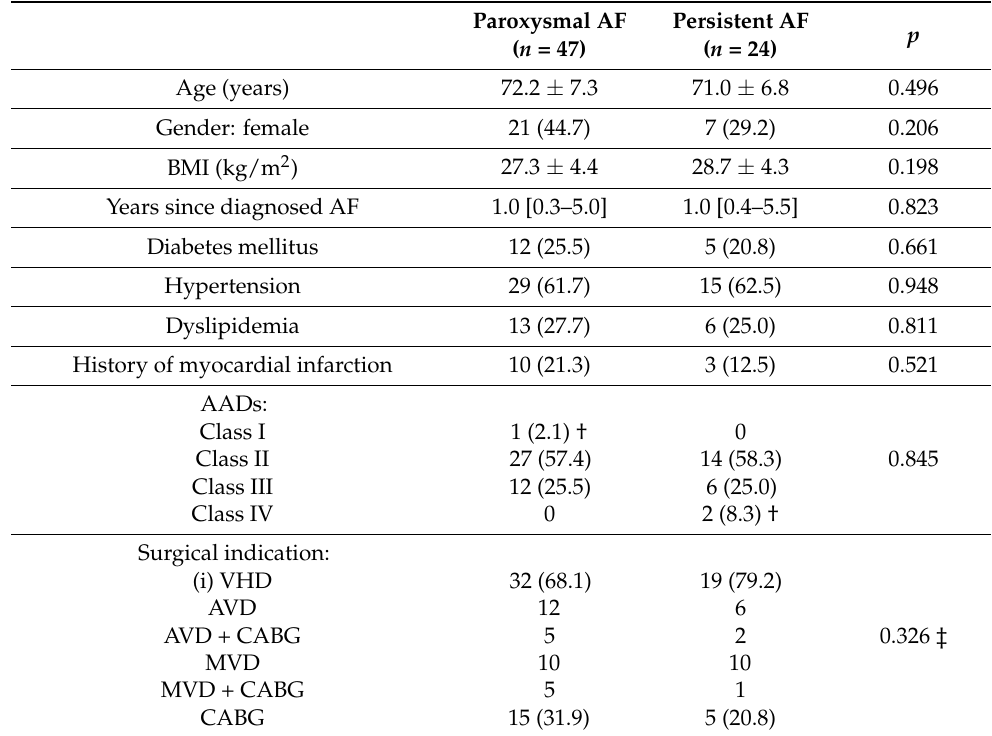
Table 1. Baseline